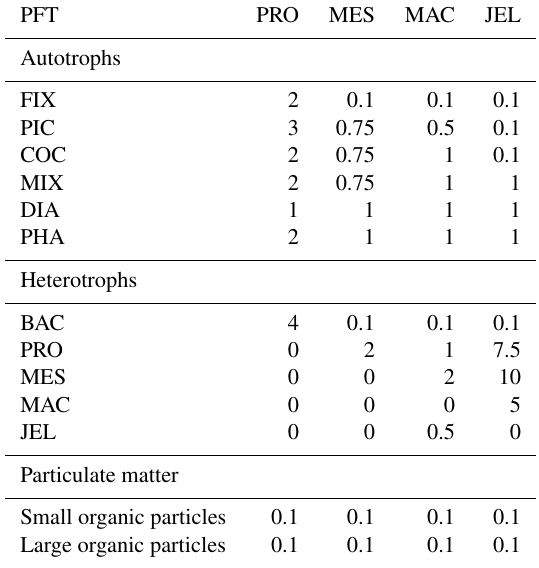
Table 3. Relative preference, expressed as a ratio, of zooplankton for food (grazing) used in PlankTOM11. For each zooplankton, the preference ratio for diatoms is set to